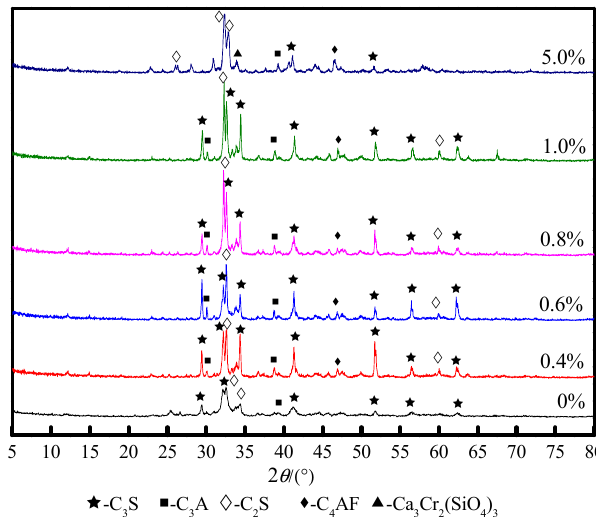
Table 4. Ionic radius, coordination number, and electronegativity of ions.